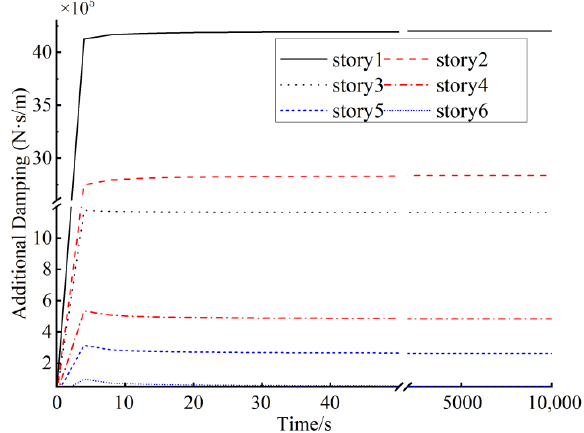
√ t : optimization of additional Figure 10. ( )= g t t : optimization of additional damping. Figure 10. g ( t ) =